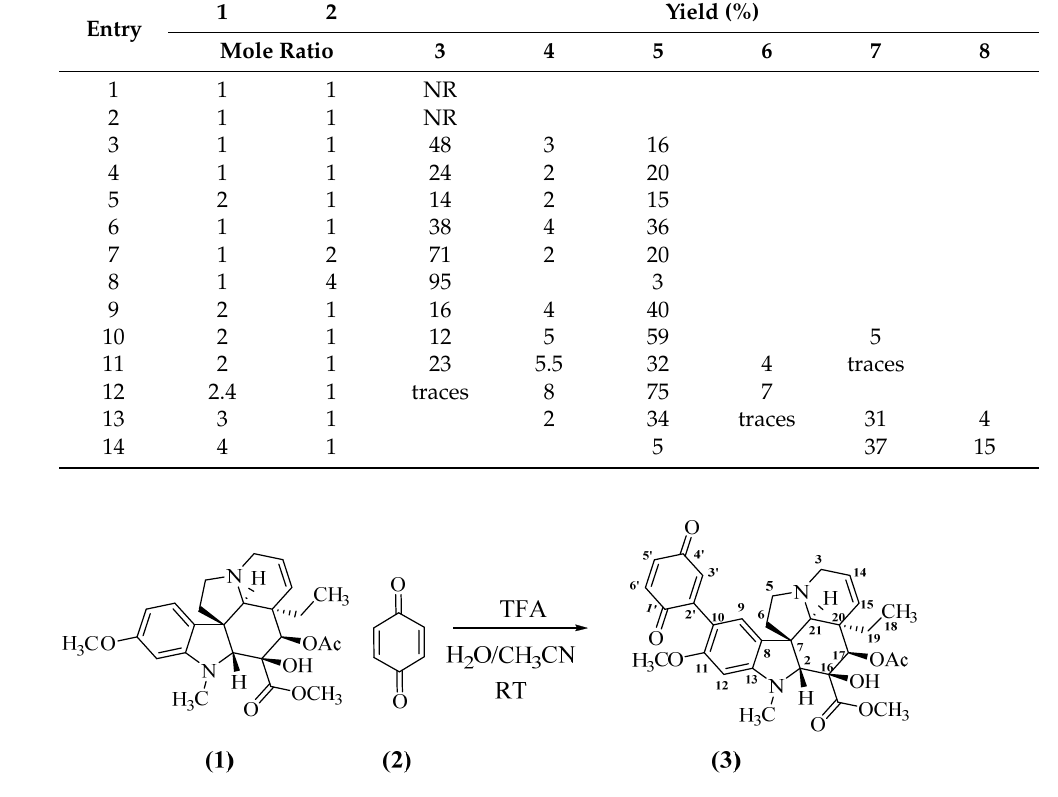
Scheme 2. Formation of the mono-adduct of vindoline and benzoquinone. Table 1. Products obtained with vindoline 1 addition to benzoquinone 2 . Reaction conditions: